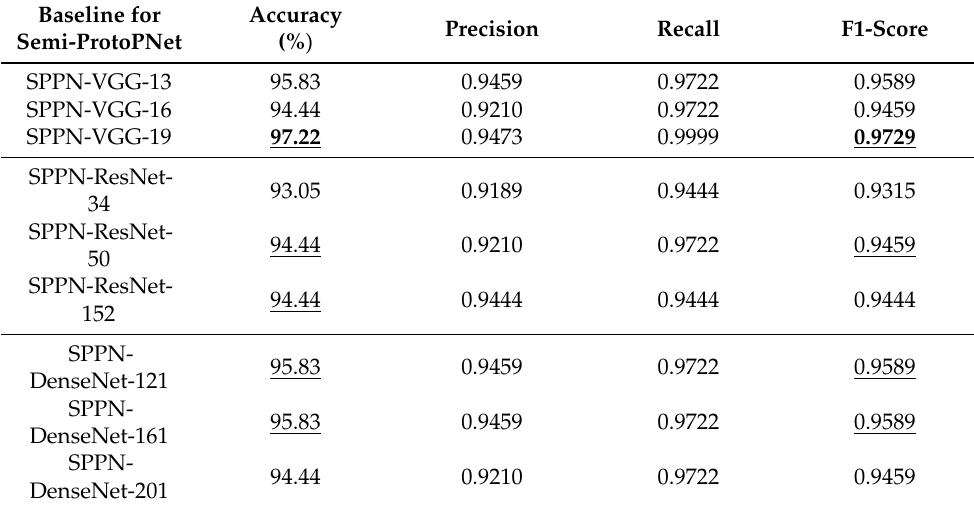
Table 3. Evaluation of the Semi-ProtoPNet with different